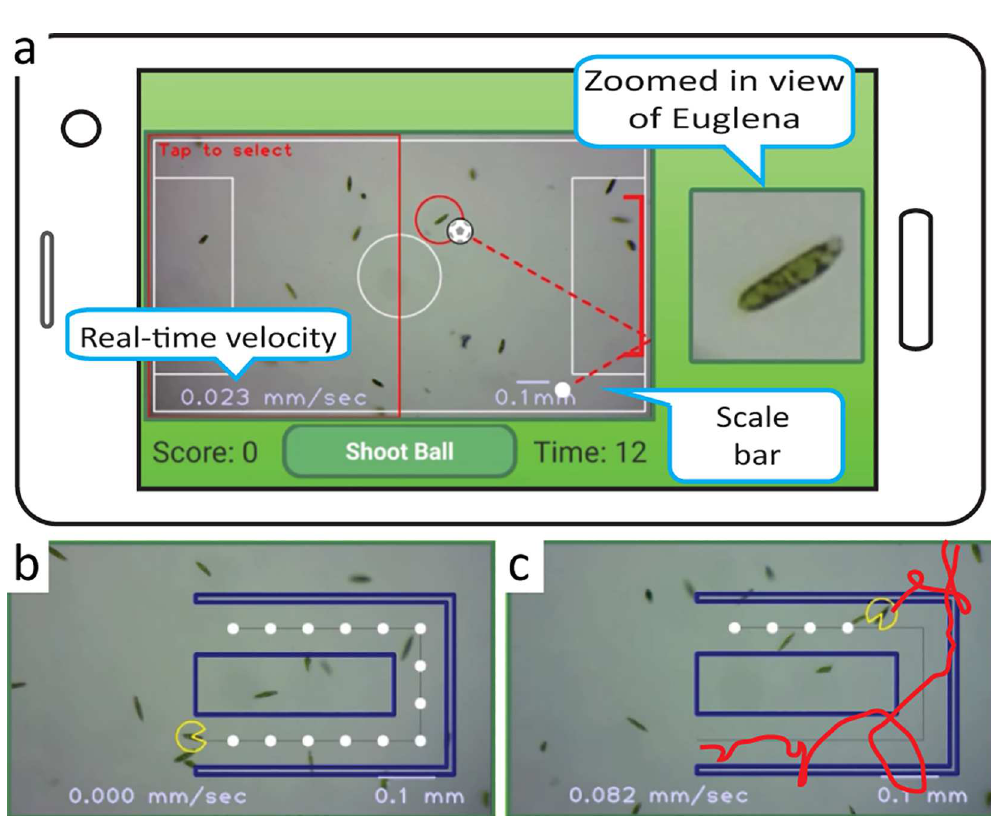
Fig 3. PLAY: The interactive microscope platform enablesbioticgame play withlive cells. ( A ) Soccer-like game sequence in which the virtualball is picked up, aimed,and carriedor passed by Euglena toward the goal. The positionof the ball is alignedwith the swimming directionof Euglena .The screen emphasizesfeatures relevant for biology education (cell speed,size, shape, and behavior). ( B ) Othergames can be developed, such as “Pac Euglena”. ( C ) The sequence shows a convoluted path as the player triesto get the Euglena aroundthe path. At the end of the game, the swimming path recorded duringthe game is displayed onscreen, connectinggame play with educationally relevant content.(S4